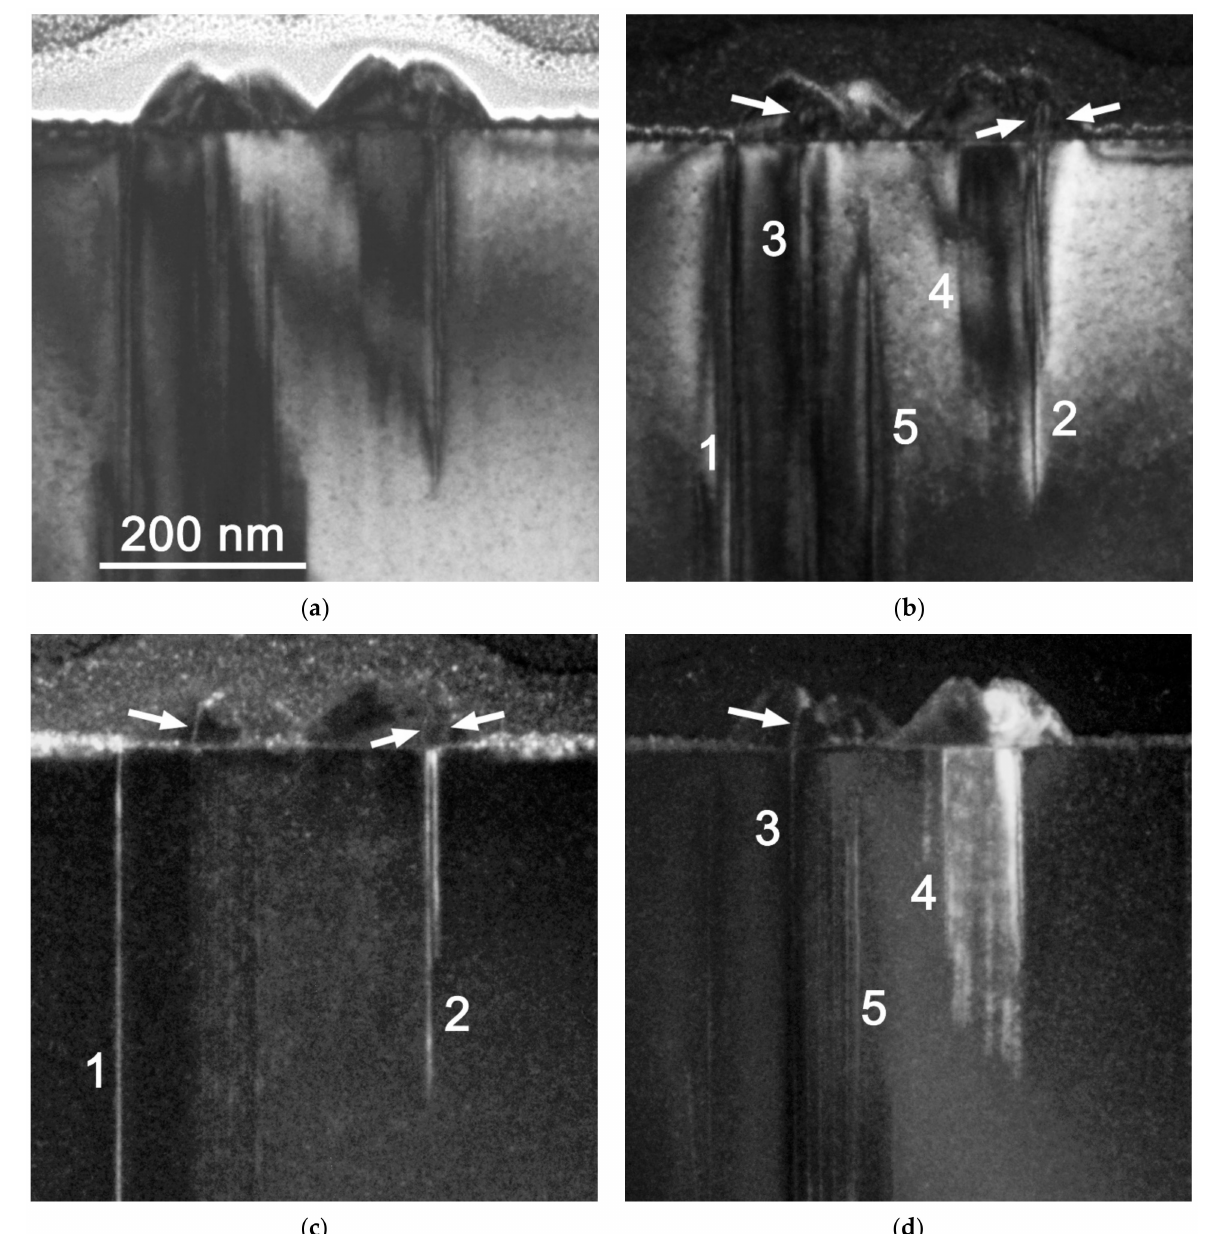
(cid:2) (cid:3) 1210 InN direction. Dislocation contrast variation (cid:2) (cid:3) 1210 and weak-beam DF images using